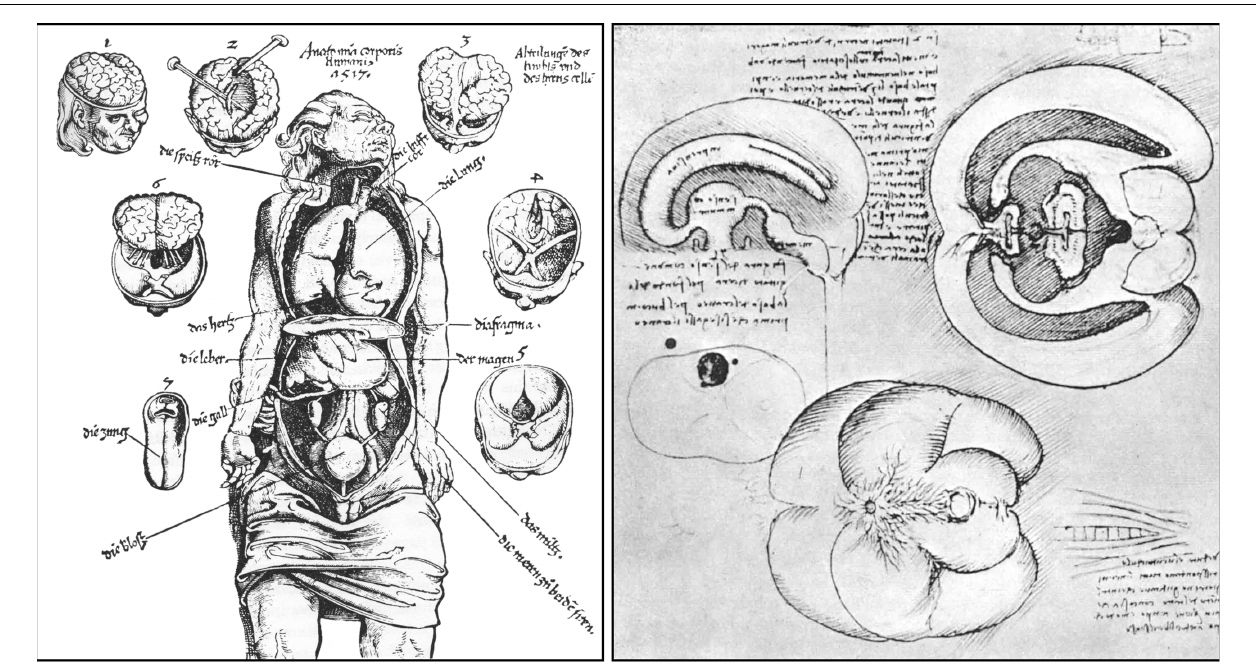
FIGURE 5 | Left: a woodcut included in Phryesen’s Spiegel der Arzney that appeared in Strasburg in 1518. The figure (folio 9v) displays a human body down to the knee, with the thoracic and abdominal cavities cut open, and surrounded by small figures representing six different stages of a human brain dissection. The names of the parts are given mostly in German. Right: details from a figure (plate QC7r) drawn by Leonardo da Vinci around 1504–1507. The sketch in the upper left portion of the figure illustrates the ventricular system, as visualized following wax injection in the cerebral ventricles of an ox. The drawing at the bottom of the figure depicts the base of a human brain covered, in part, by a spidery structure corresponding to the rete mirabile (from Parent,